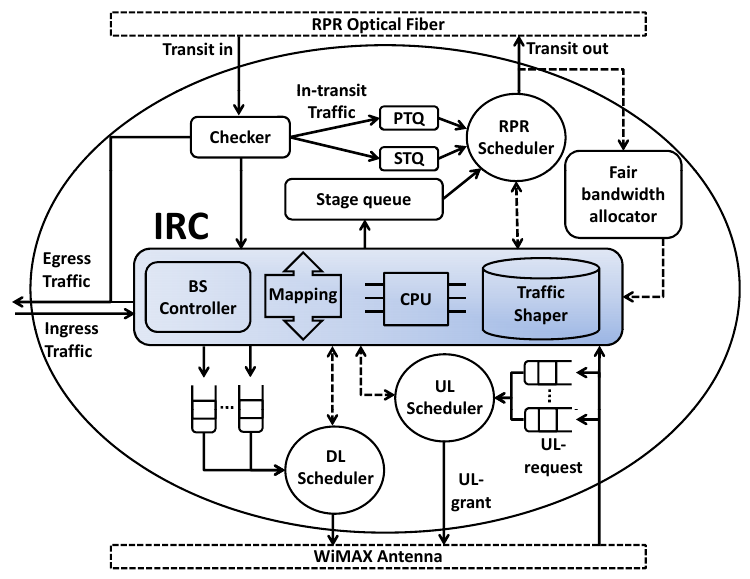
Figure 7. Optical-wireless interface between RPR and WiMAX networks.